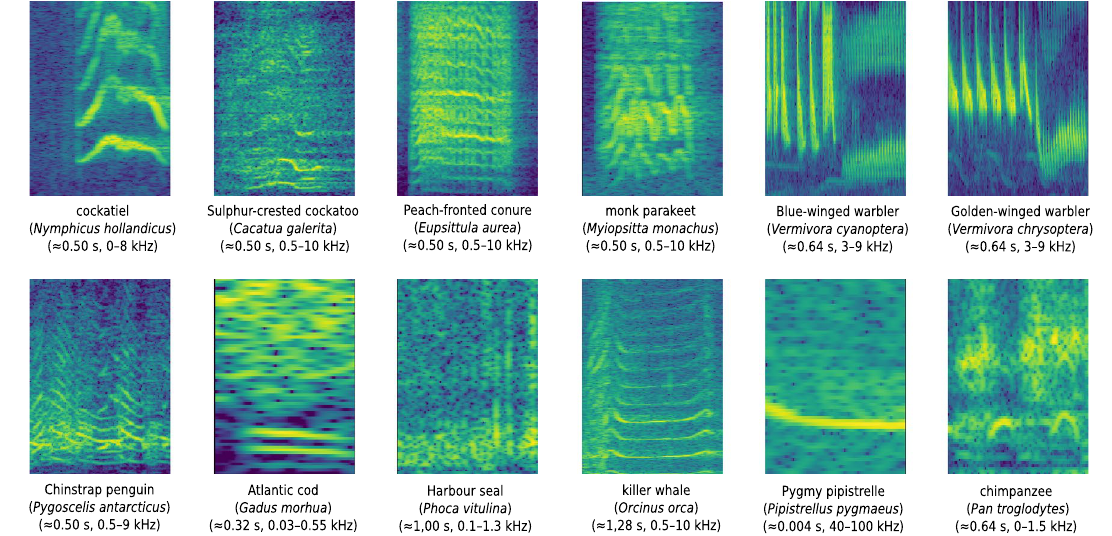
Figure 3. ANIMAL-SPOT preprocessed 256 × 128-large network input spectrograms (256 frequency bins, 128 time frames) utilizing animal-specific network-hyperparameters listed in Supplementary Table S2 (created via Inkscape 39 , Version